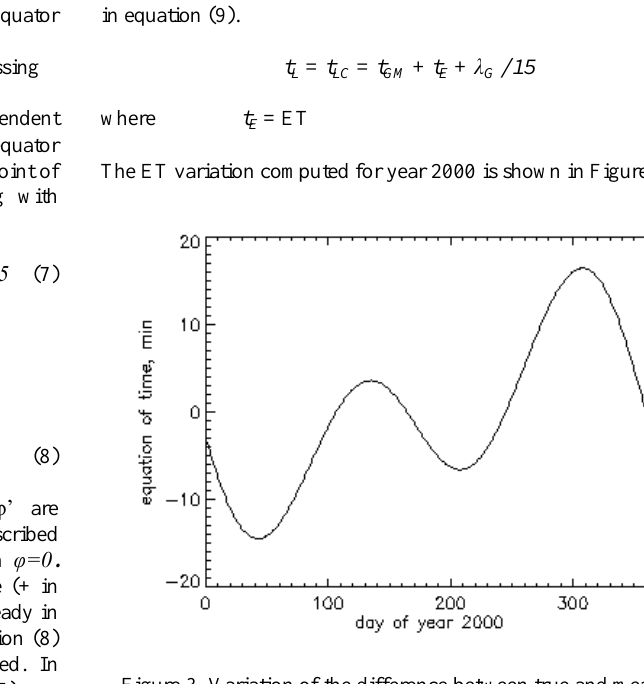
Figure 3. Variation of the difference between true and mean solar time calculated for year